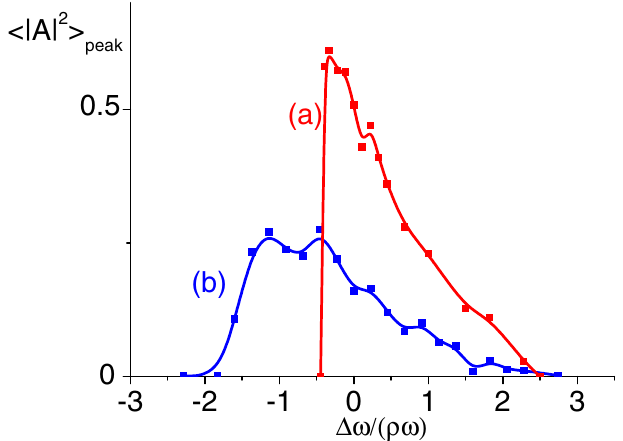
versus " for the case of Fig. 5, with n peak (cid:4) 50 (cid:11) m and 0 (cid:4) 0 : 8 and L 0